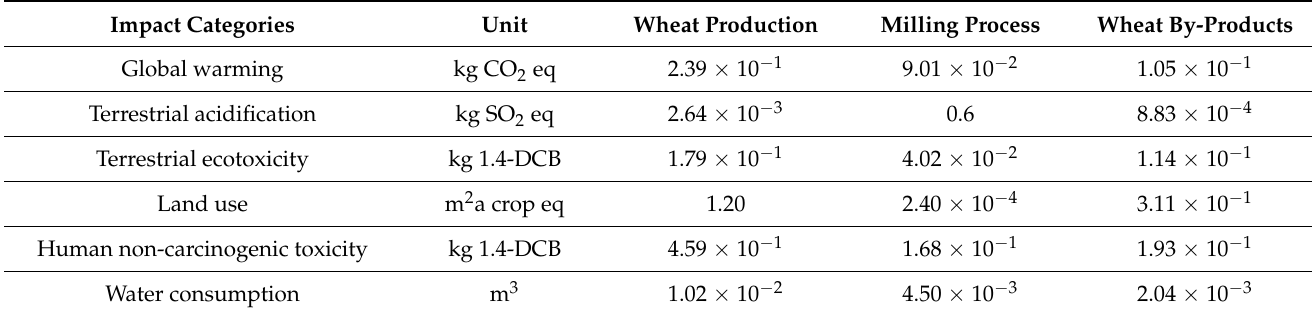
Table 5. LCIA results for wheat production process compared to wheat by-products. Unit Wheat